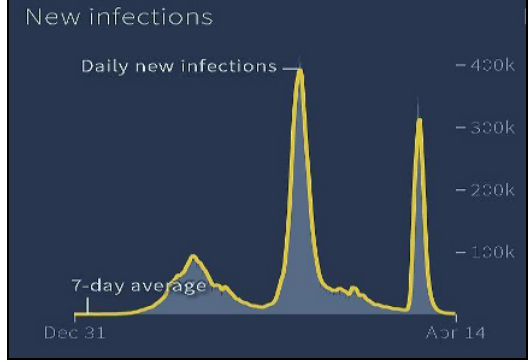
Fig. 1. Daily reported trends in India